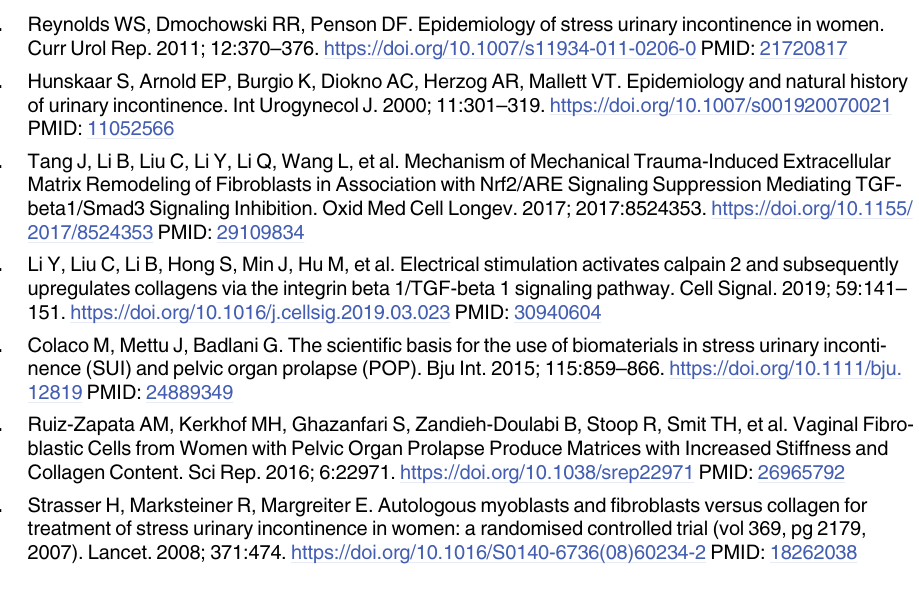
S2 Table. Supplemental table of the protein